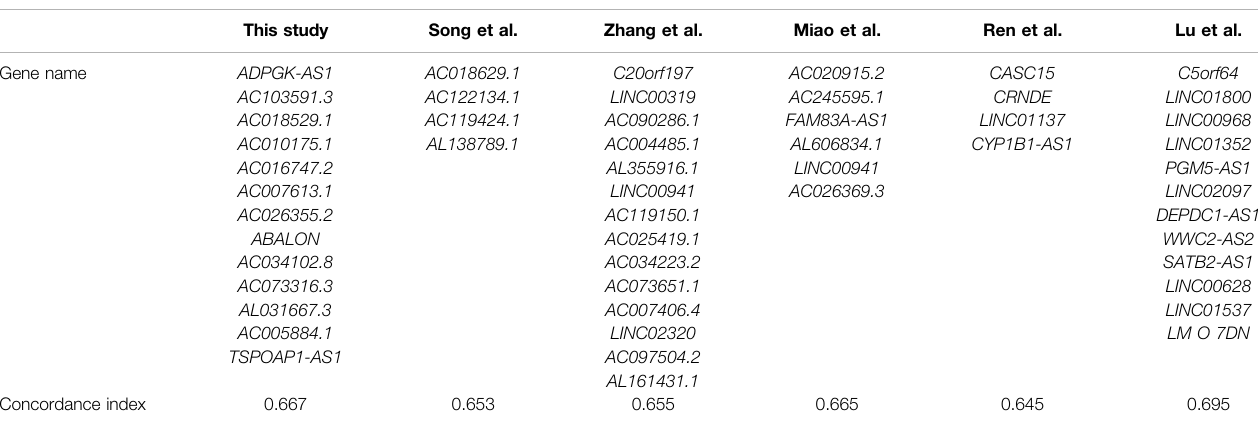
TABLE 2 | The concordance index of already existing lncRNAs based model for LUAD. This study Song et al. Zhang et al. Miao et al. Ren et al. Lu et